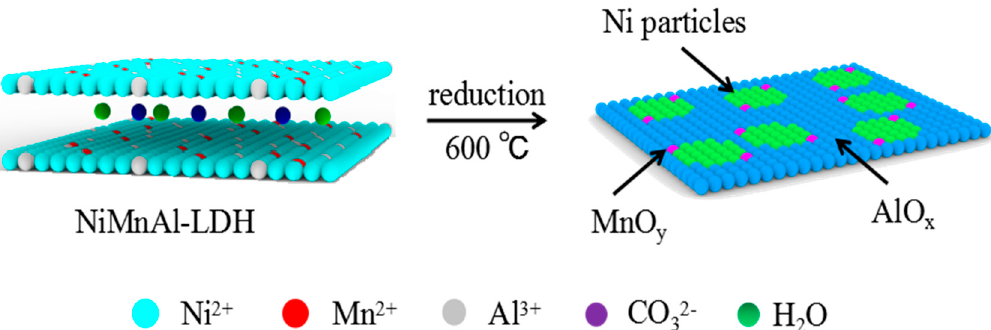
Figure 8. Schematic diagram of the structure of the catalyst.